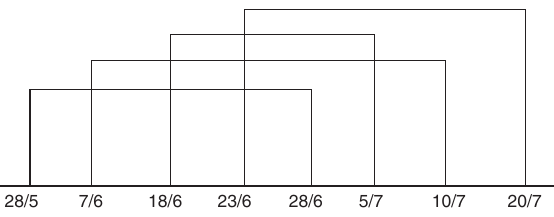
Figure 2. Overlapped Subintervals for Finding a Yearly Pattern { a , c }.